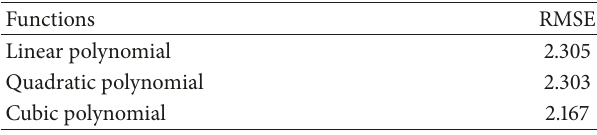
Table 2: RMSE about the regressive polynomial